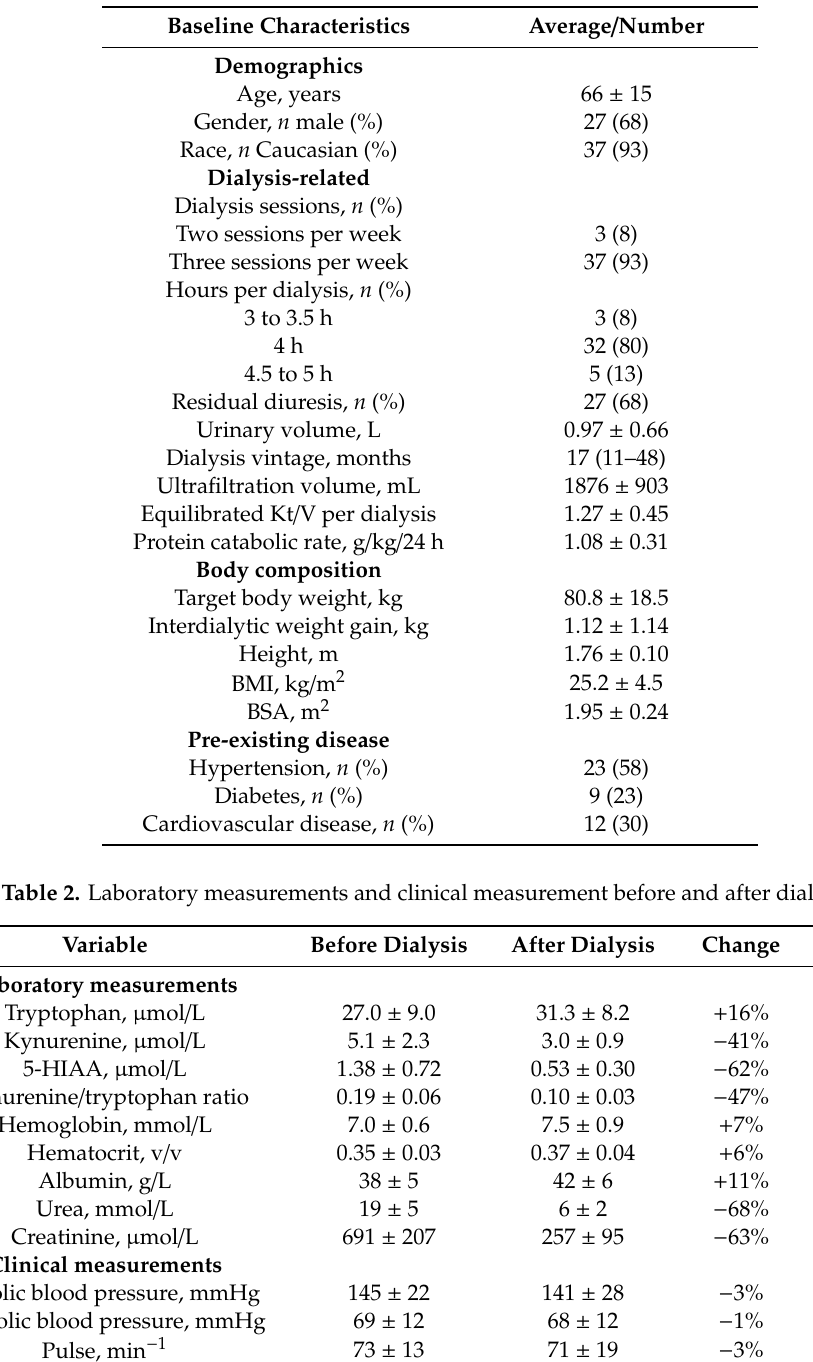
Table 1. Patient characteristics.